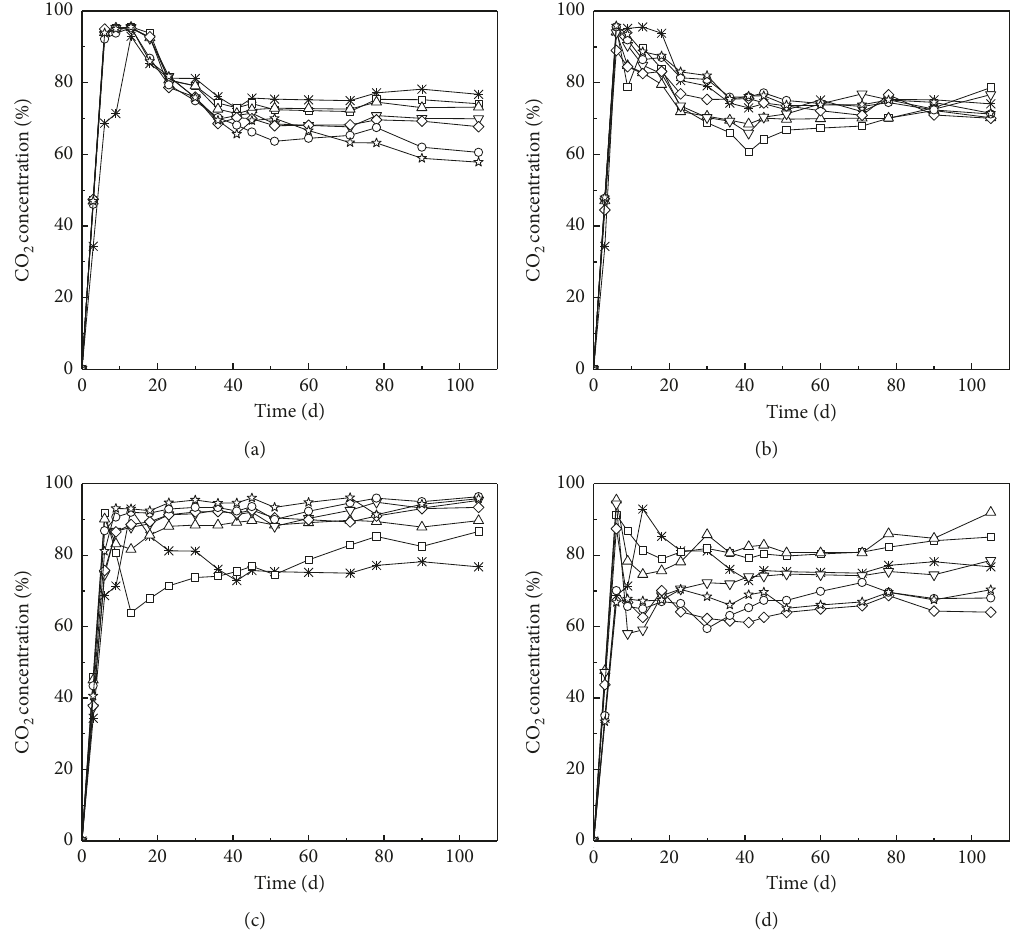
· kg − 1 ; △ , 8000mg · kg − 1 ; ▽ , 16000mg · kg − 1 ; ◇ ,